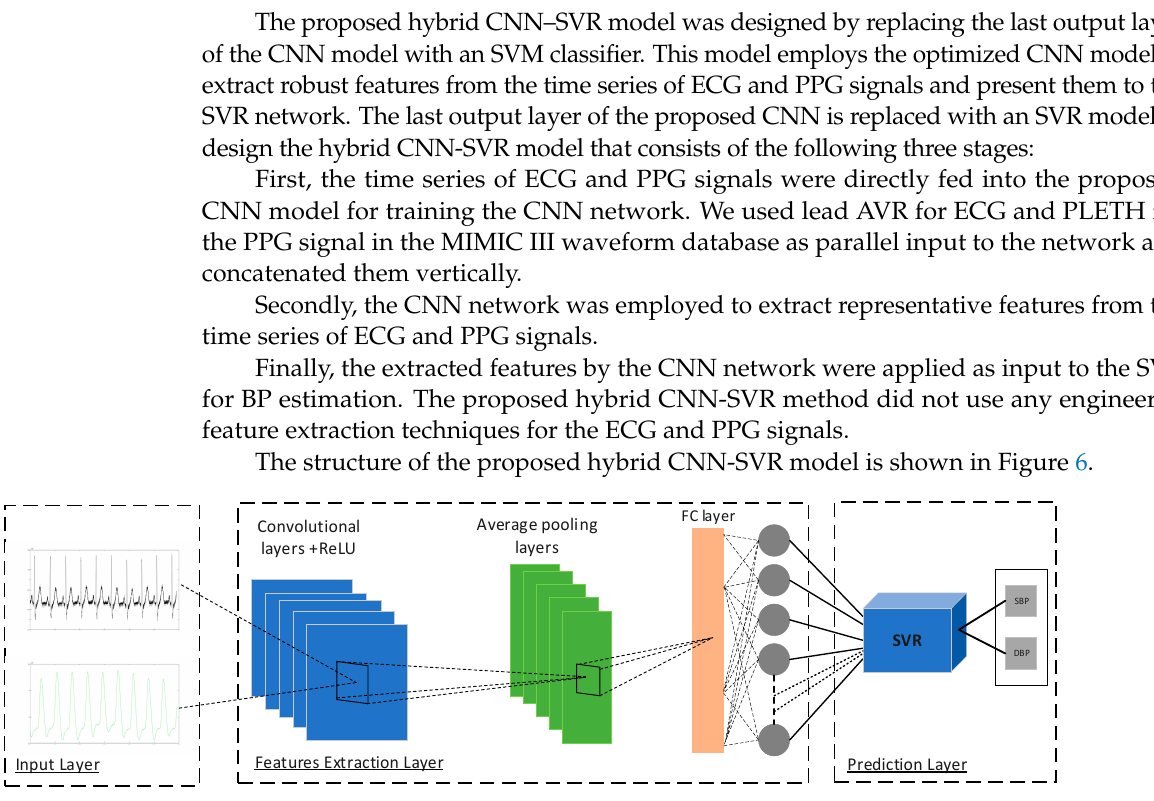
Figure 6. Structure of the CNN-SVR model. For feature extraction with CNN, five convolutional layers are used. Each convolu- tional layer is followed by batch normalization, ReLU, and average pooling layers. Batch normalization can robustly handle overfitting and underfitting problems. A dropout regu- larization technique with a dropout ratio of 20% is employed to reduce overfitting before the fully connected